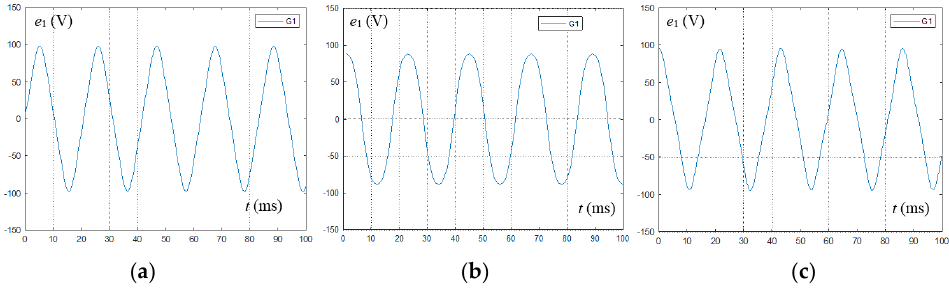
Figure 20. Waveform of induced electromotive force (EMF) (phase 1) for the basic model G1: ( a ) numerical calculations finite-element method (FEM); ( b ) analytical calculations; ( c ) laboratory measurements.